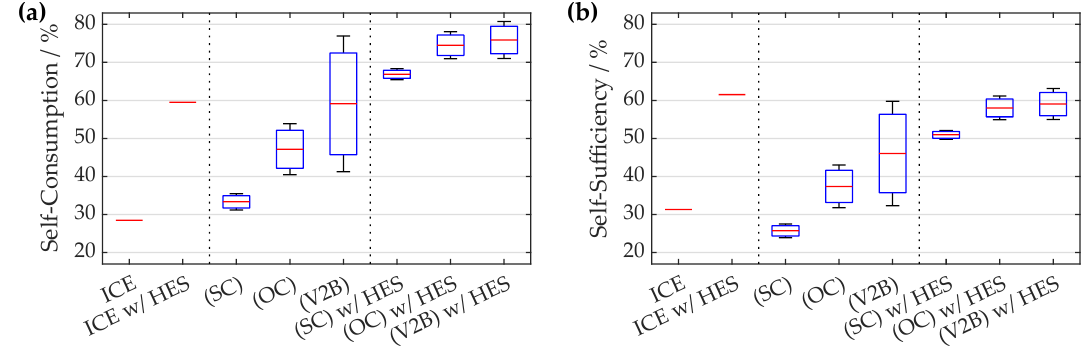
Figure 6. ( a ) Self-consumption and ( b ) self-sufficiency rate for the investigated scenarios. For both metrics, the top edge of each boxplot represents the supplementary car. The lower values of the boxplots are defined by the commuter car, which has a shorter plug-in time compared to the supplementary car.